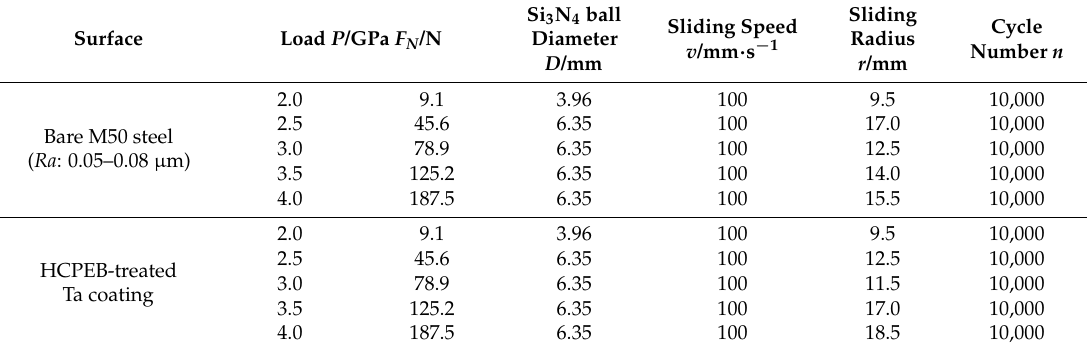
Table 1. Friction test conditions of bare (polished) M50 steel and HCPEB-treated Ta coating while sliding in pure JP-10 against a Si 3 N 4 ball at room temperature in ambient